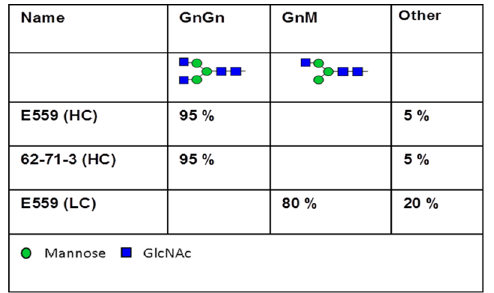
Fig 4. N-linked glycans on the anti-rabies mAbs. N-glycosylation profile from E559 HC and LC and from 62-71-3 HC as determined by LC-ESI-MS of glycopeptides obtained upon trypsin digestion. Numbers represent the presence of the different glyco-species in percent of total glycan. The N-glycan nomenclature used was from www.proglycan.com.